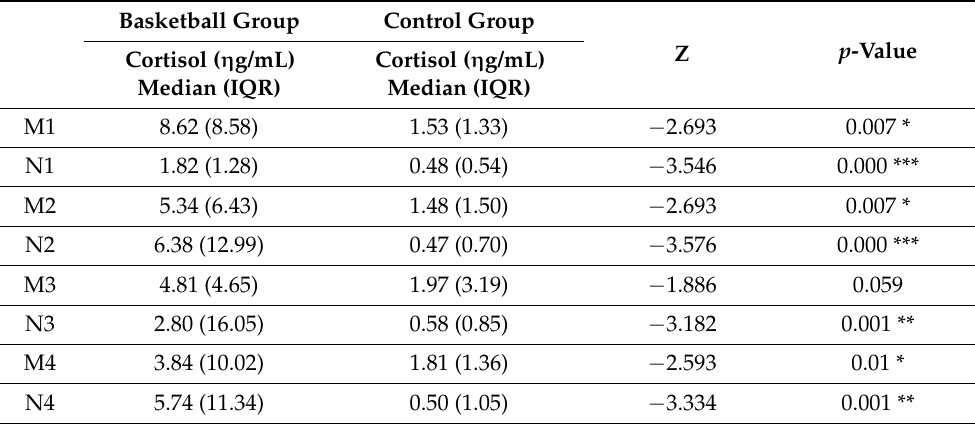
Table 2. Comparison of the quantified cortisol levels in the morning and at night on Monday, Wednesday, Friday, and Sunday, between the group that did physical exercise those days (basketball group) and the group that did not do any kind of exercise (control